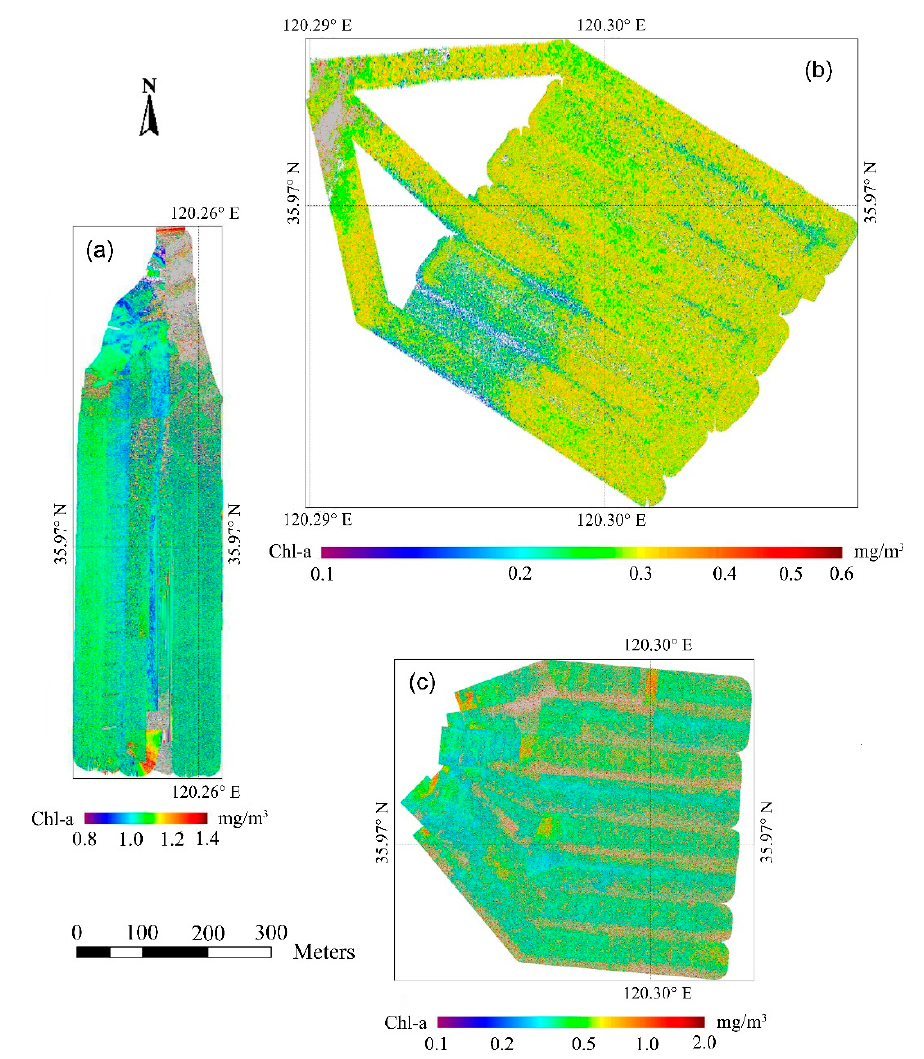
Figure 10. The estimated spatial distributions of Chl-a concentrations in the study areas on ( a )